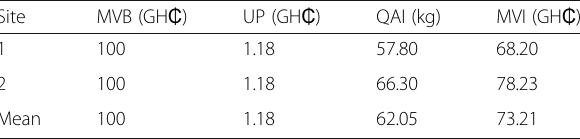
Table 4 The monetary value (GH ₵ ) of insect pollination per bag of shea kernel (85 kg) in the Guinea savanna zone of Ghana